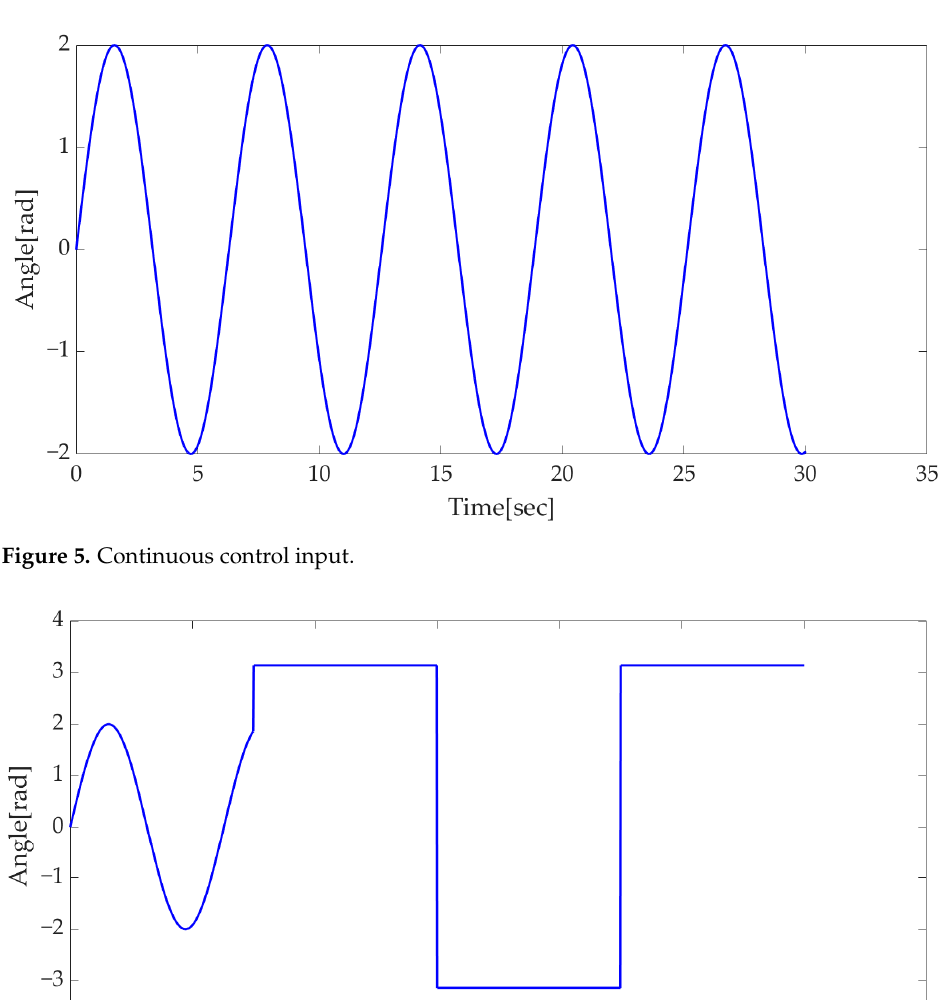
Figure 7. Disturbance. The snake robot’s head system parameter is 𝑚 (cid:2869) = 0.1 kg , 𝑚 (cid:2870) = 0.2 kg , 𝑙 (cid:2869),(cid:2870) = 0.07 m , initial angle 𝜃 (cid:2869) = 1.5 rad , θ (cid:2870) = 1.8 rad , θ(cid:4662) (cid:2869),(cid:2870) = 0 rad/s , and θ(cid:4663) (cid:2869),(cid:2870) = 0 rad/s (cid:2870) . The control gain parameter is